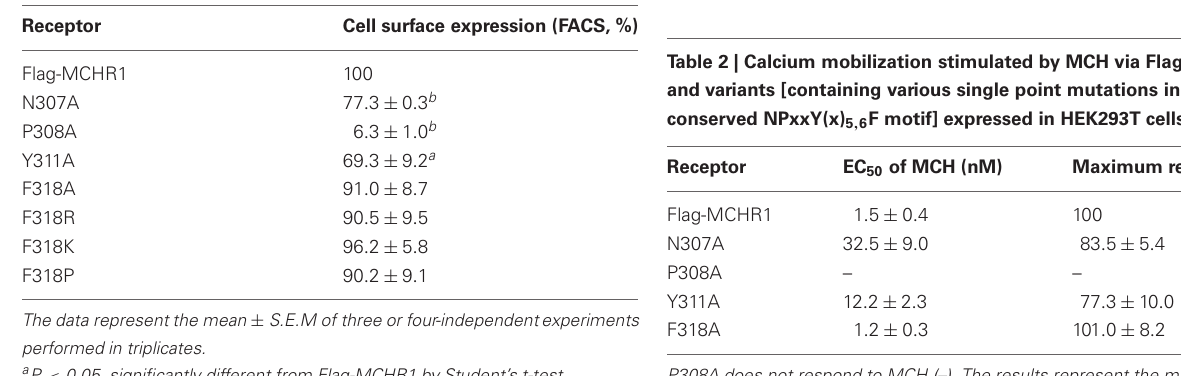
Table 1 | Cell surface expression of Flag-MCHR1 and variants transiently expressed in HEK293T